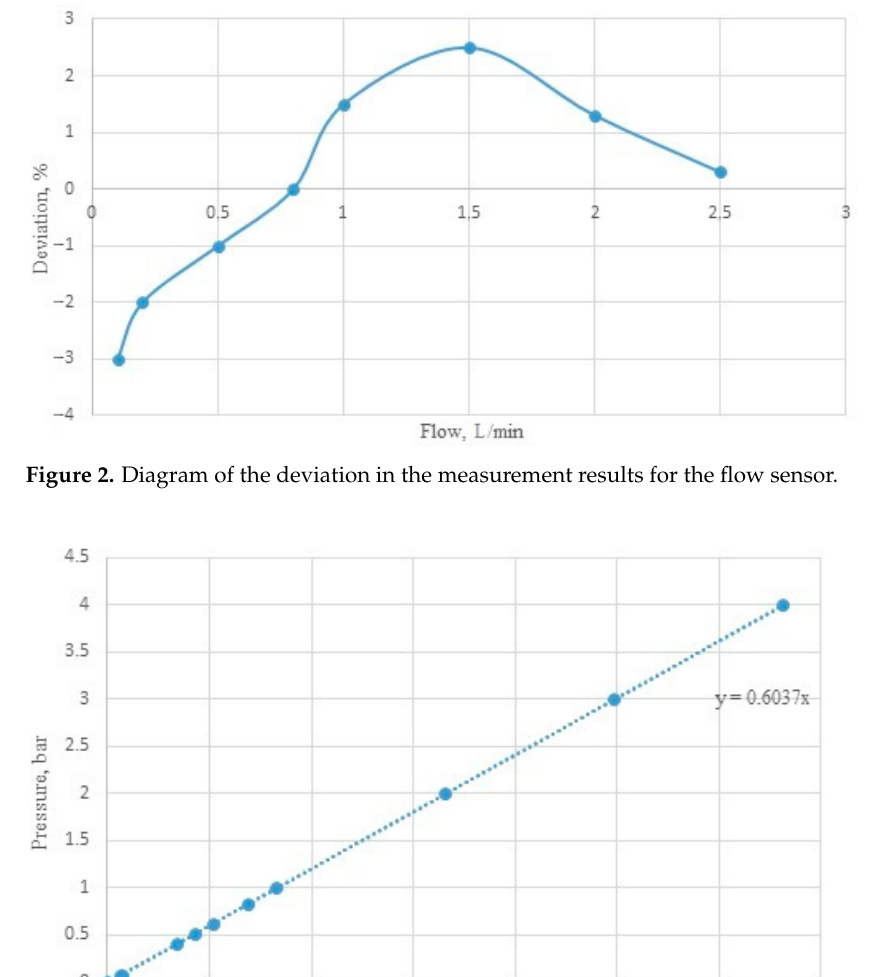
Figure 2. Diagram of the deviation in the measurement results for the flow sensor.